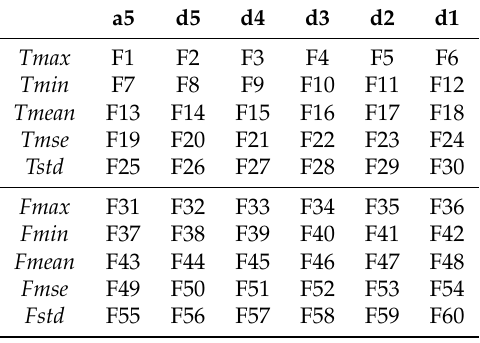
Table 2. Feature Extraction of MRA.